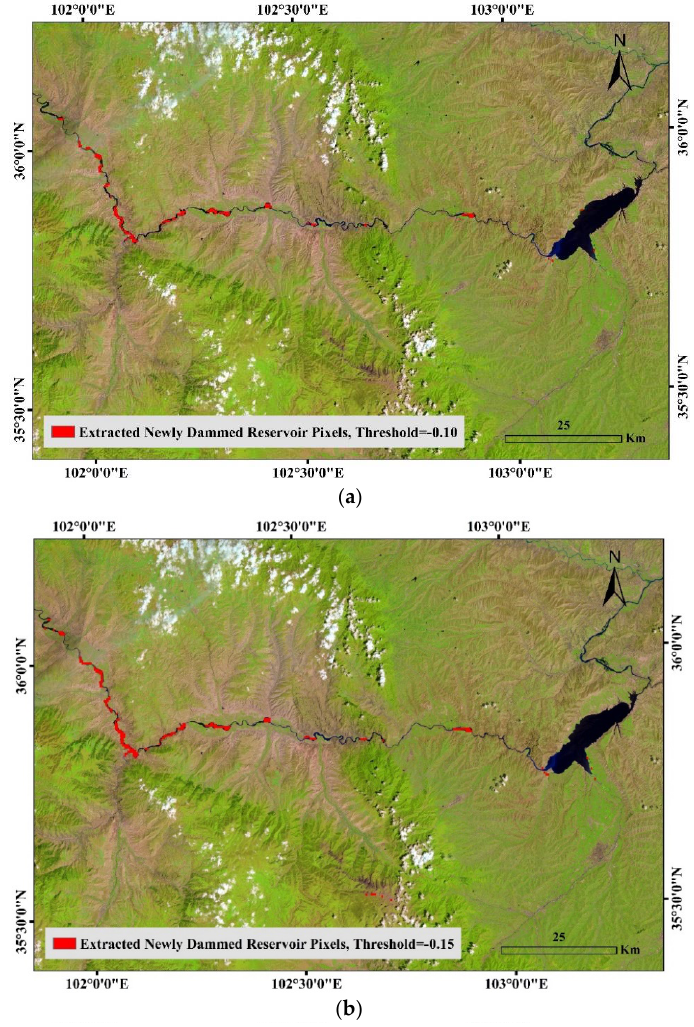
Figure 11. Averages of trend components of water area pixels before (left) and after (right) break their point, influenced by different settings of h parameter sampled in water ( a ) and land ( b ) area. Values in x -axis indicate different settings of h parameter, while values in y -axis indicate averages of trend components before or after break points. Each line drawn in the diagram indicates average of trend components in each sample pixel influenced by different settings of h parameter. They were